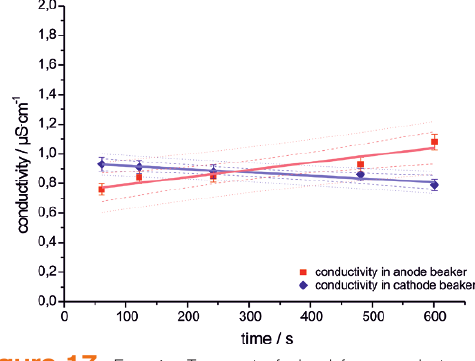
Figure 17. Exp. 4a: Transport of glycol from anode to cathode beaker, conductivity measurement evaluated with a linear fit including 95% confidence (dashed) and 95% prediction (dotted) intervals.